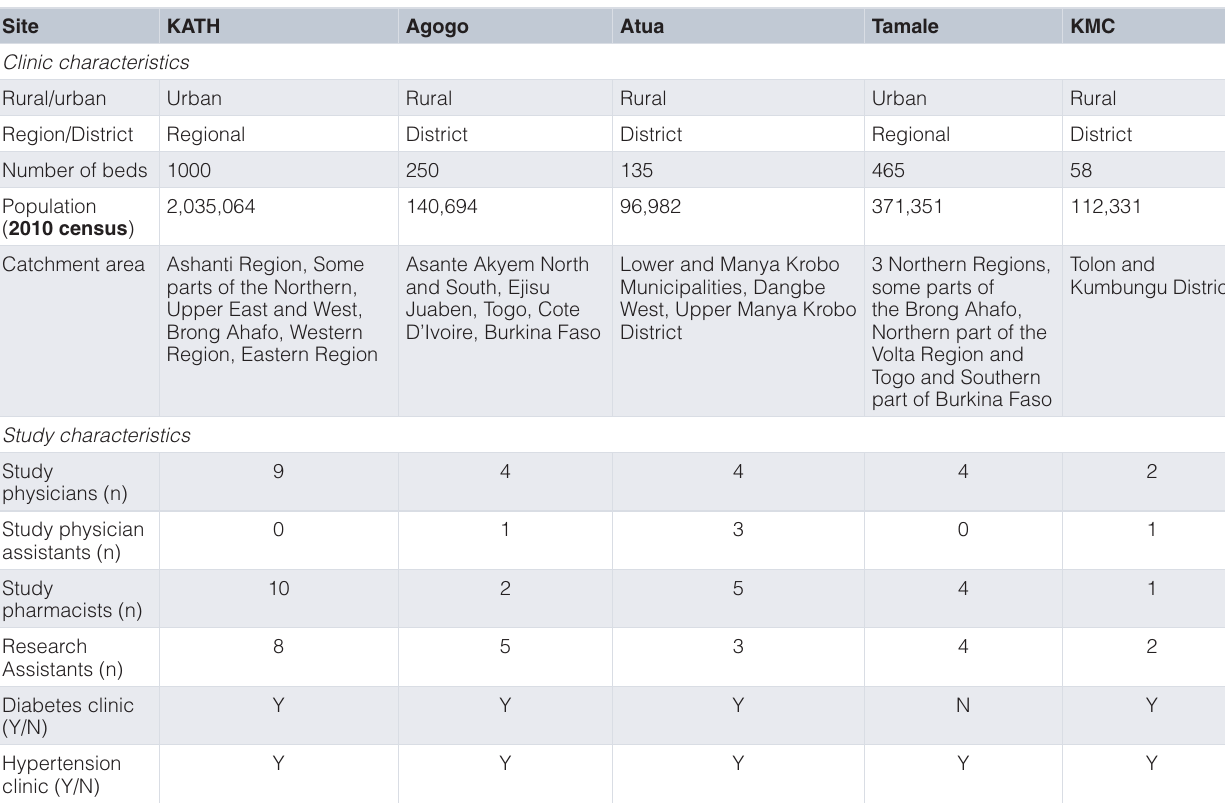
Table 1. Characteristics of study